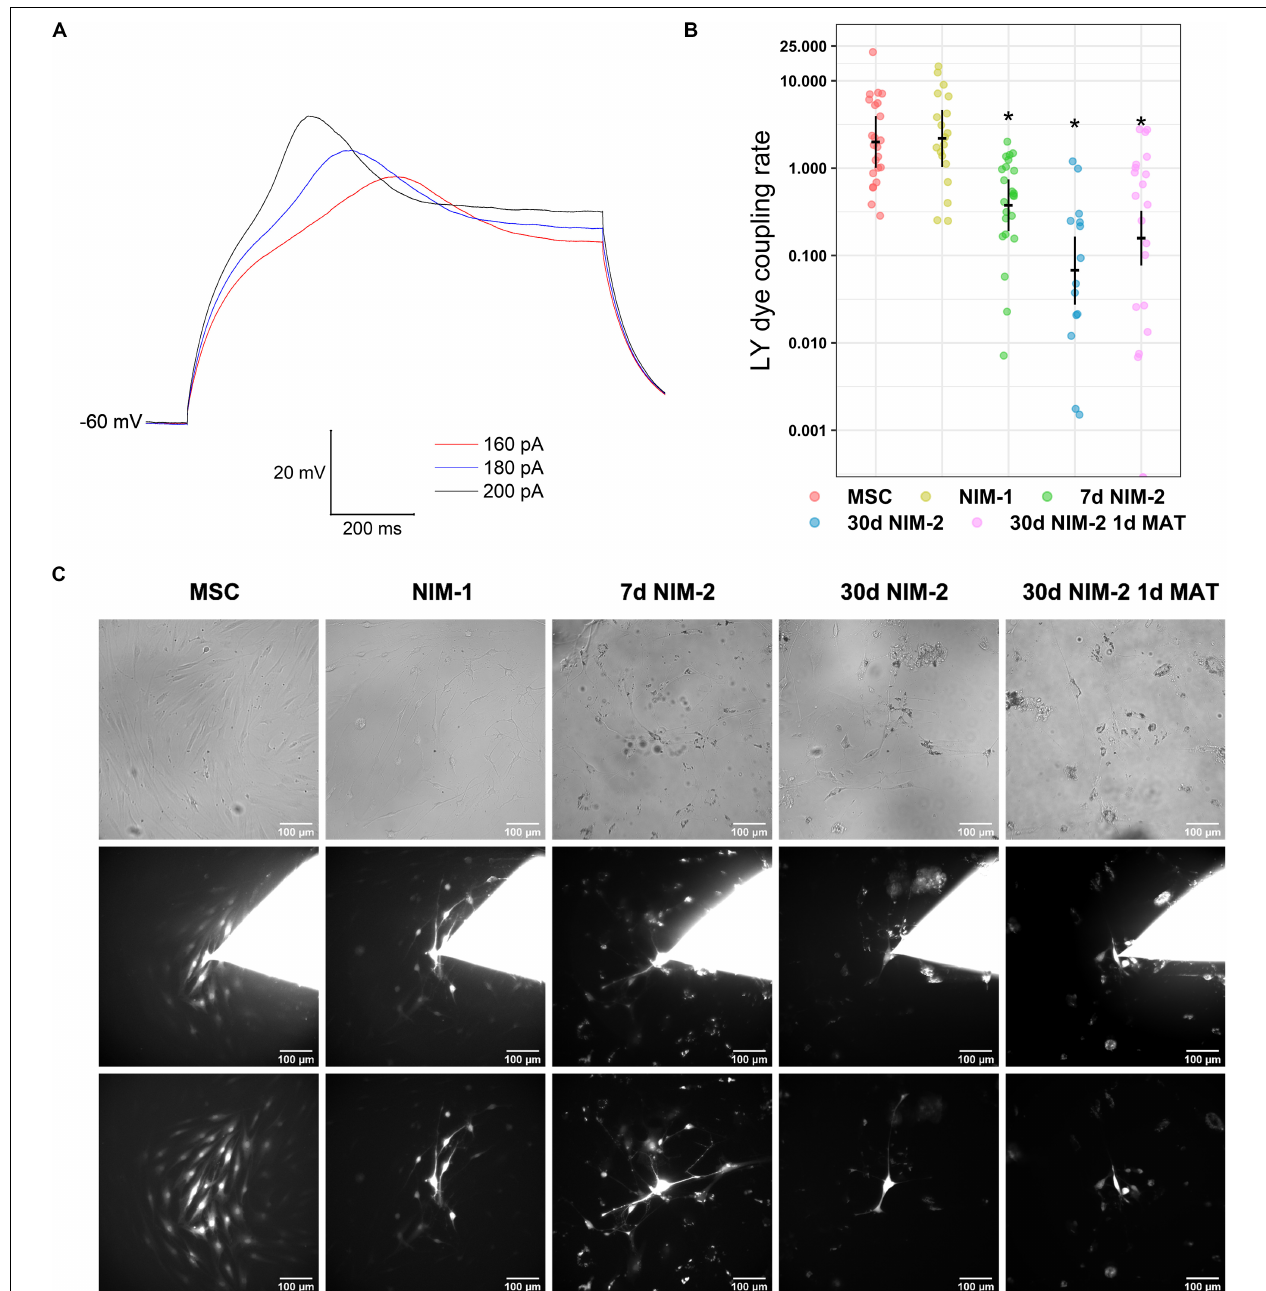
FIGURE 2 | Electrophysiological properties and gap junction coupling in differentiated MSCs. (A) Membrane potential recordings in a 30 d NIM-2 1 d MAT-differentiated cell measured in the whole-cell patch-clamp configuration. Action potentials were evoked by the injection of depolarizing currents of 160–200 pA. (B) Quantification of the dye transfer experiments. The original data points are plotted in colorful dots. The horizontal lines indicate model-based least-square means together with their 95%-confidence intervals (vertical lines). The * marks significant mean differences ( α = 0.05) between MSCs and the differentiated cells. (C) Exemplary micrographs of LY dye transfer experiments. Phase contrast images captured before the experiment are shown in the first row. The second row shows the cells during the dye transfer experiment with the patch pipette still attached onto the cell. In the third row, micrographs of the dye transfer experiment are displayed, which were captured after removing the patch pipette to evaluate the degree of gap junction coupling. The scale bars indicate 100 µ m.